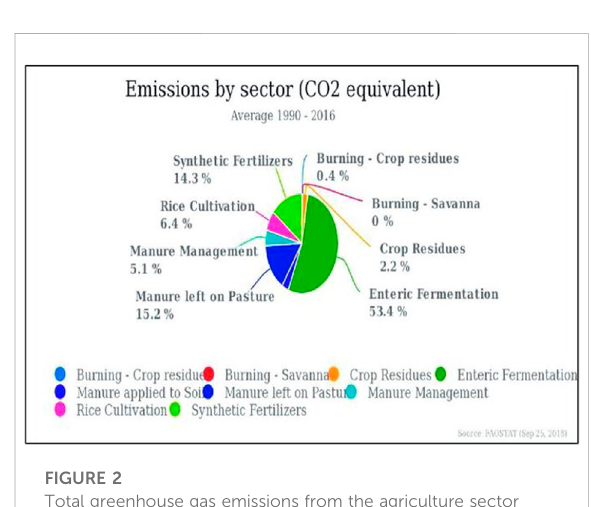
FIGURE 2 Total greenhouse gas emissions from the agriculture sector in Pakistan. Source: FAOSTAT,